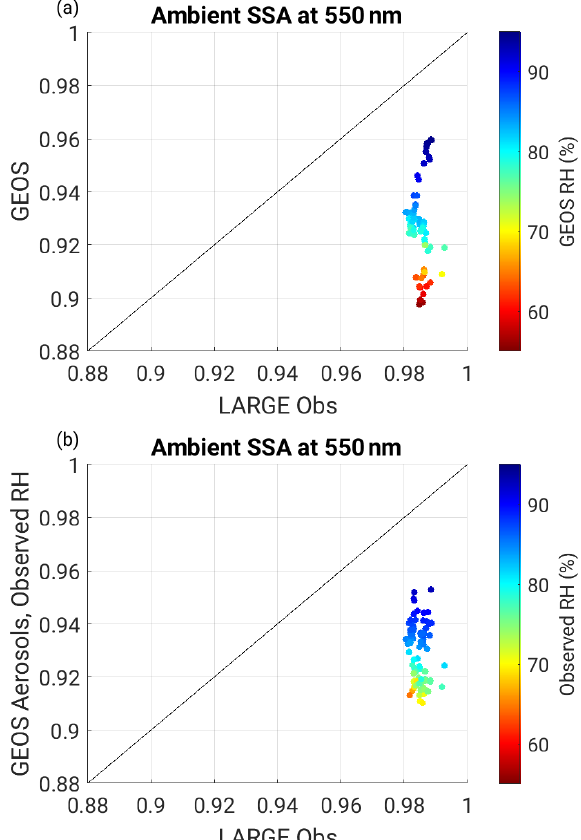
Figure 11. Ambient single-scattering albedo at 550nm computed using (a) the relative humidity from GEOS and (b) observed rela- tive humidity from the aircraft versus the observed single-scattering albedo for the flight segment from RF9. Points are colored based on the relative humidity in GEOS in panel (a) and the observed relative humidity in panel (b)